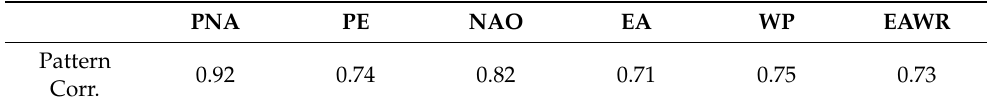
Table 2. Pattern correlation coefficient (PCC) of six teleconnection patterns between the GloSea5 model and ERA5 reanalysis data. PNA PE NAO EA WP EAWR Pattern 0.92 0.74 0.82 Corr.